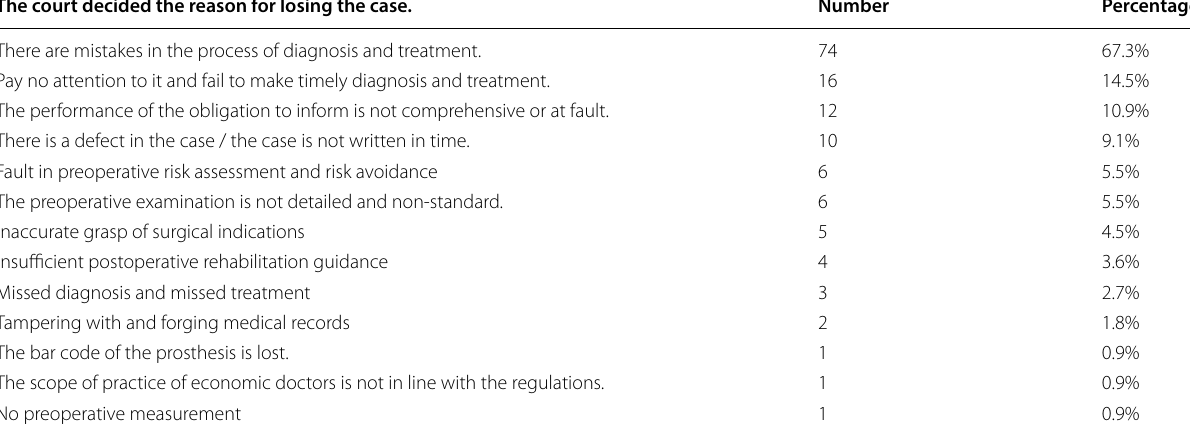
Table 5 The number and proportion of reasons determined by the court to lose the case in the collection of litigation cases of total knee arthroplasty